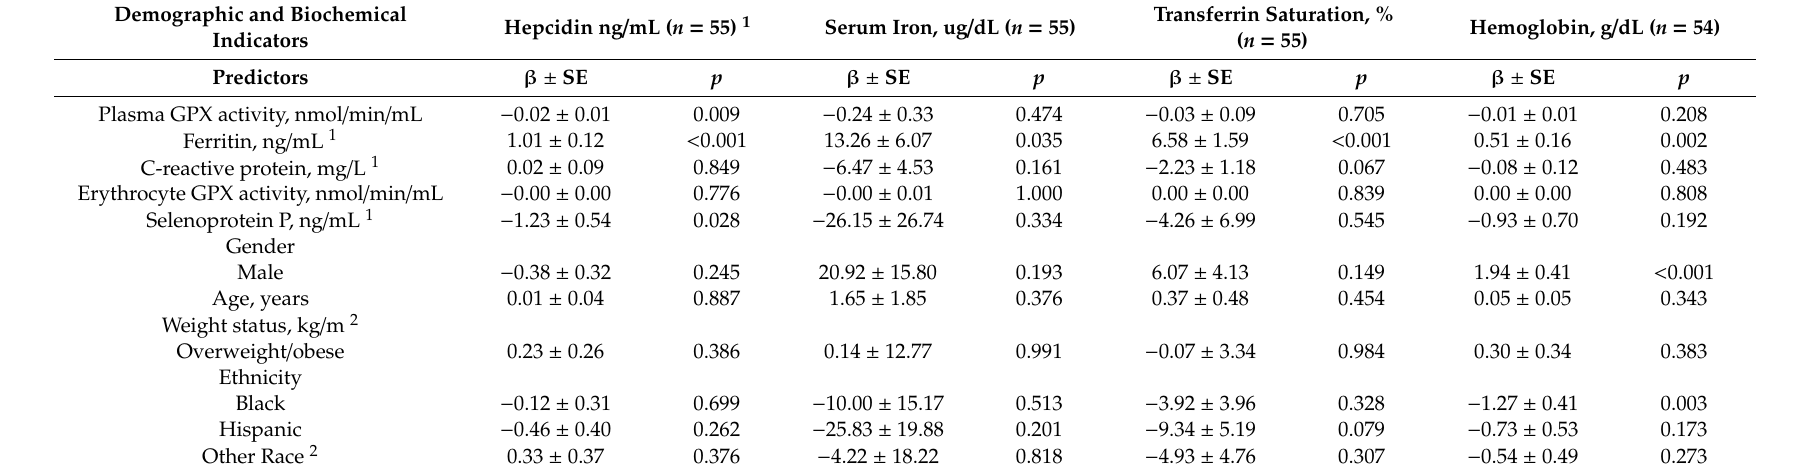
Table 3. Association between iron status biomarkers and selenoproteins in young adults with normal weight or overweight / obesity. Demographic and